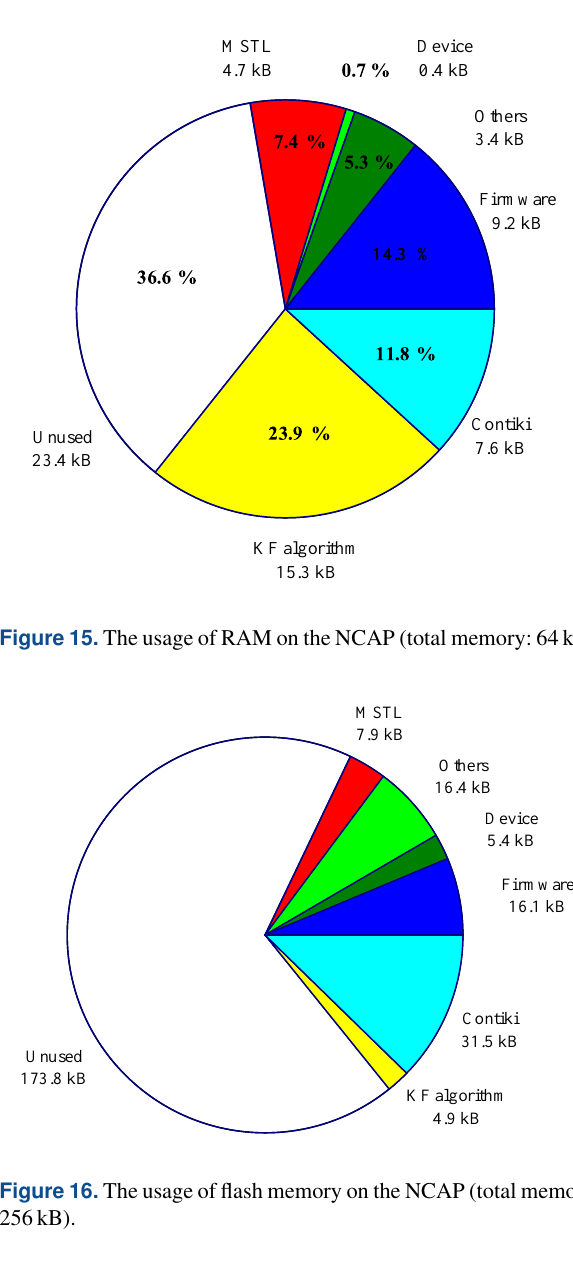
Figure 16. The usage of flash memory on the NCAP (total memory: